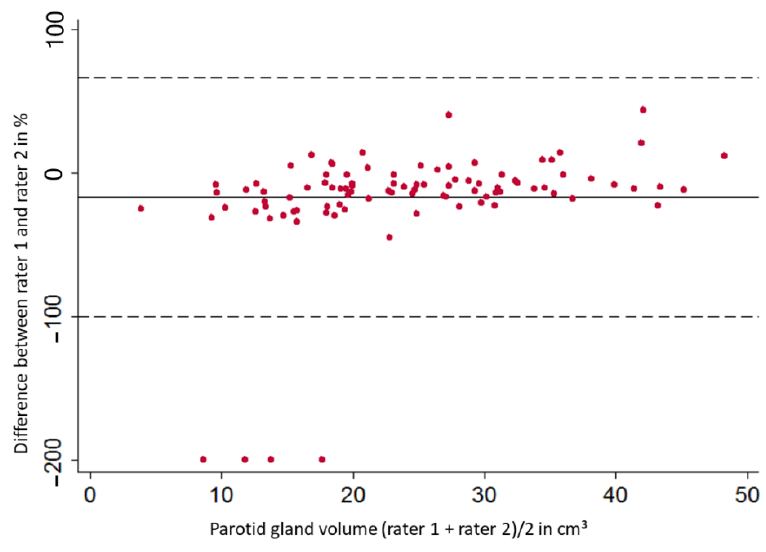
Figure 3. Bland-Altman plot for interrater reliability of right parotid glands.